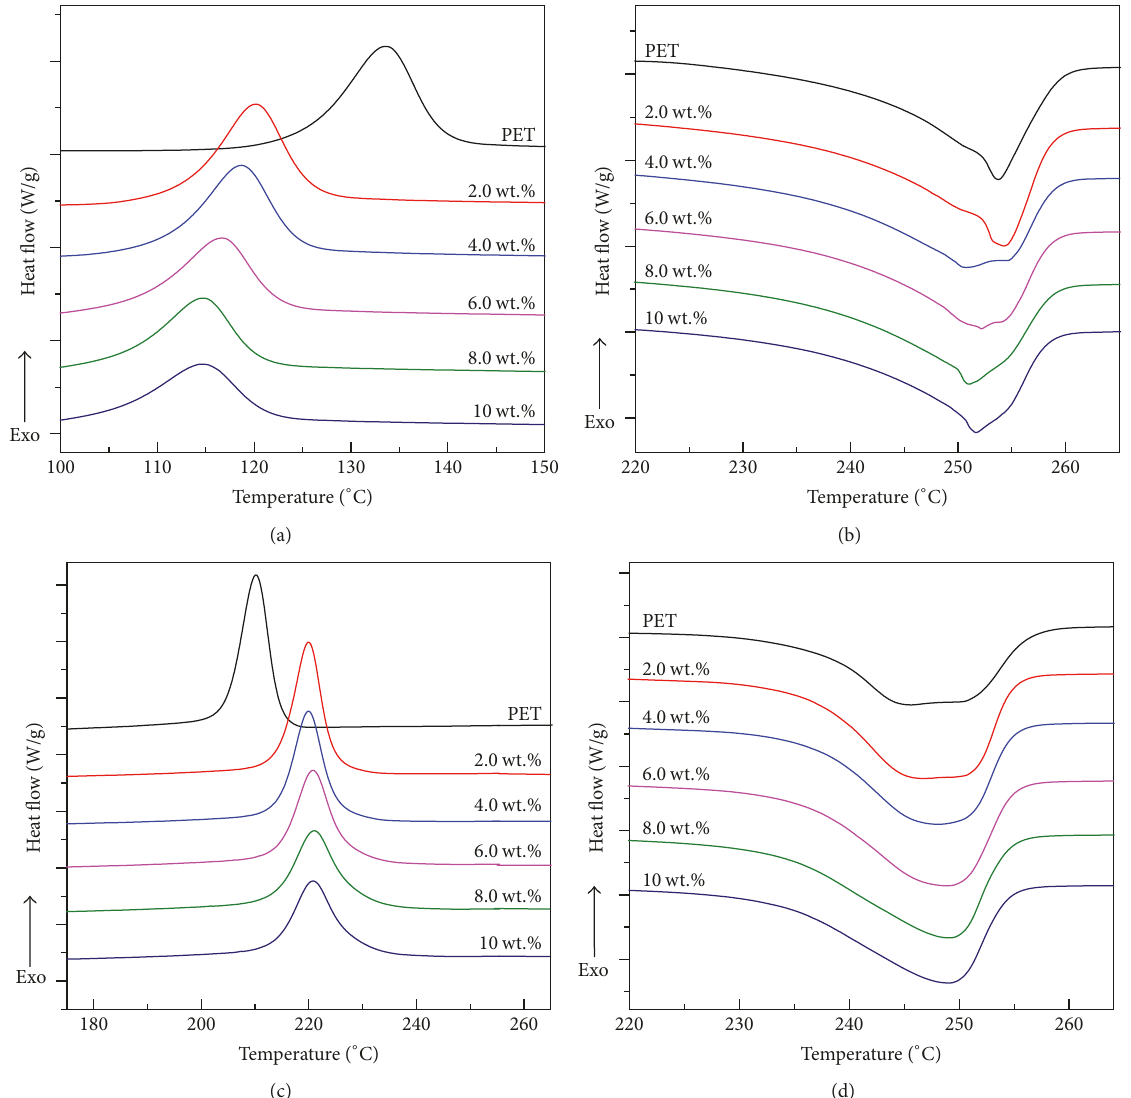
Figure 9: DSC curves of PET-GNP nanocomposites showing cold crystallization peaks (a), melting peaks from the first scan (b), subsequent cooling curves (c), and melting peaks from second heating run